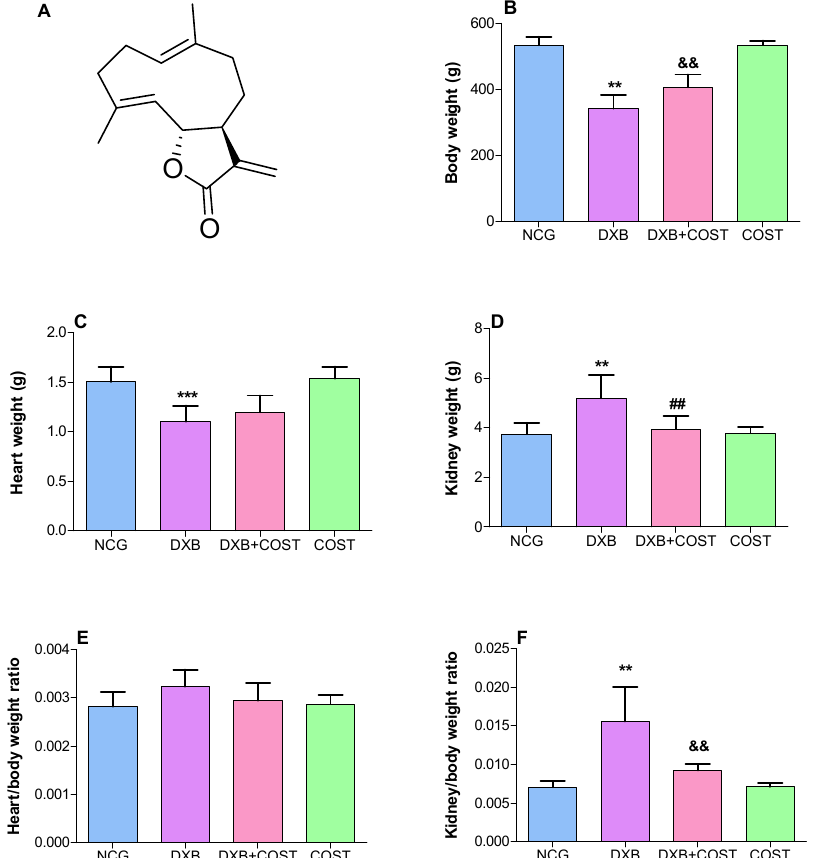
Figure 1. ( A ): Chemical structure of costunolide. Effect of costunolide on: ( B ): body weight gain, ( C ): heart weight, ( D ): kidney weight, ( E ): heart/body weight ratio, ( F ): kidney/body weight ratio. ** Statistically significant ( p < 0.01) when compared with NCG and COST groups. && Statistically significant ( p < 0.01) compared with DXB group. *** Statistically significant ( p < 0.05) compared with NCG and COST groups. ## Statistically significant ( p < 0.05) compared with DXB group.